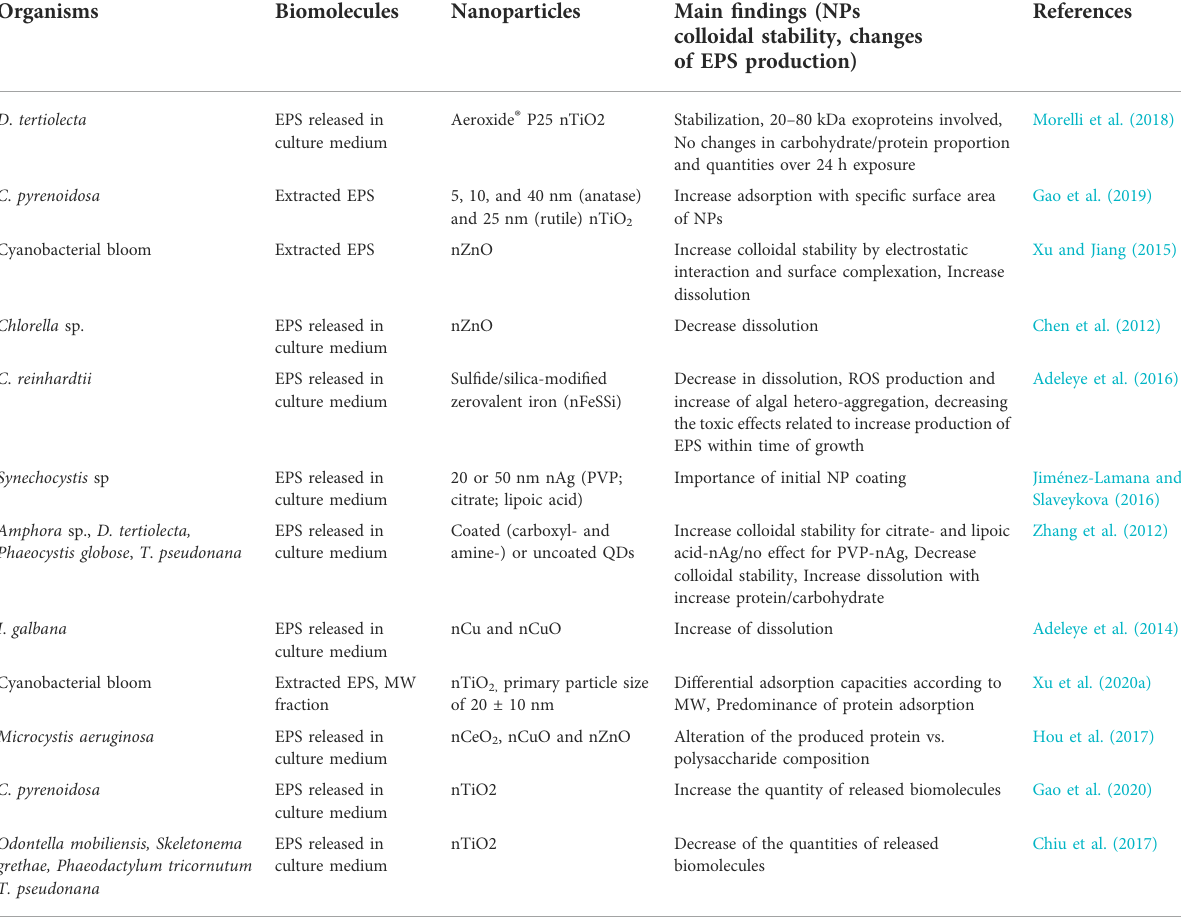
TABLE 1 Selected examples to illustrate the interaction between released biomolecules from phytoplankton and